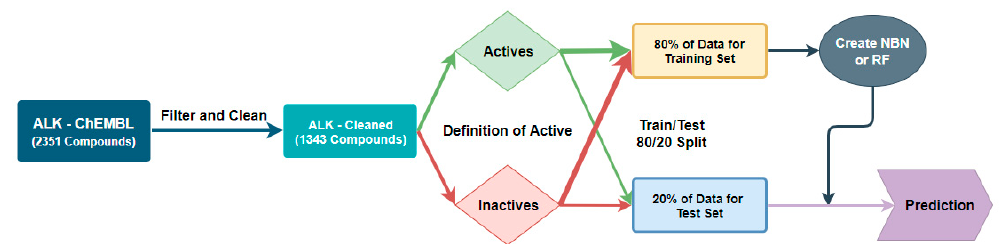
Figure 2. Workflow for classification threshold evaluation in the Naïve Bayes Network (NBN) and Random Forest (RF) algorithms.